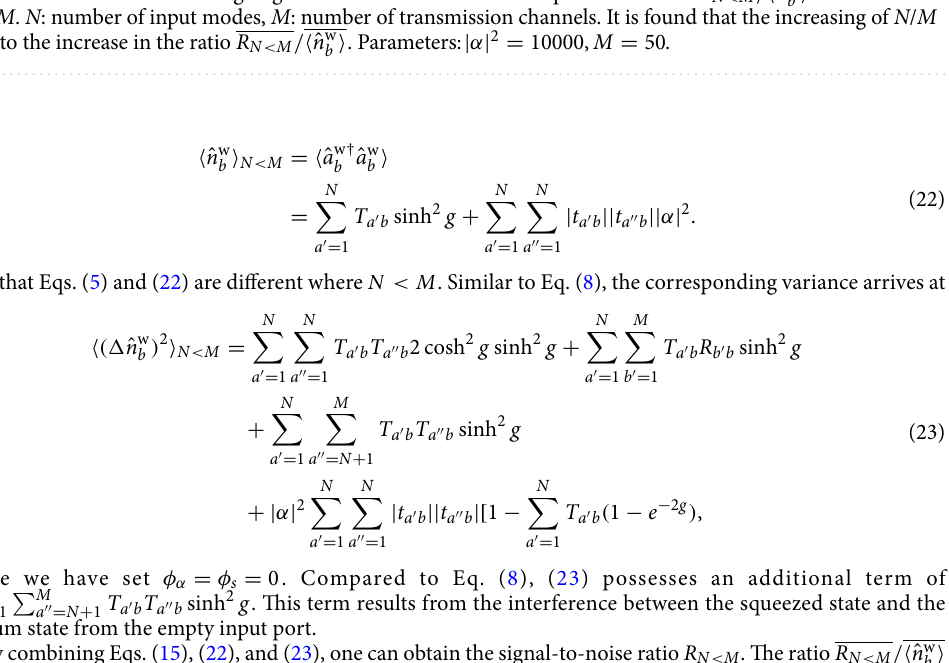
Figure 6. The ratio of the average signal-to-noise ratio to the mean photon number R N < M / of N / M . N : number of input modes, M : number of transmission channels. It is found that the increasing of N / M leads to the increase in the ratio R N < M /